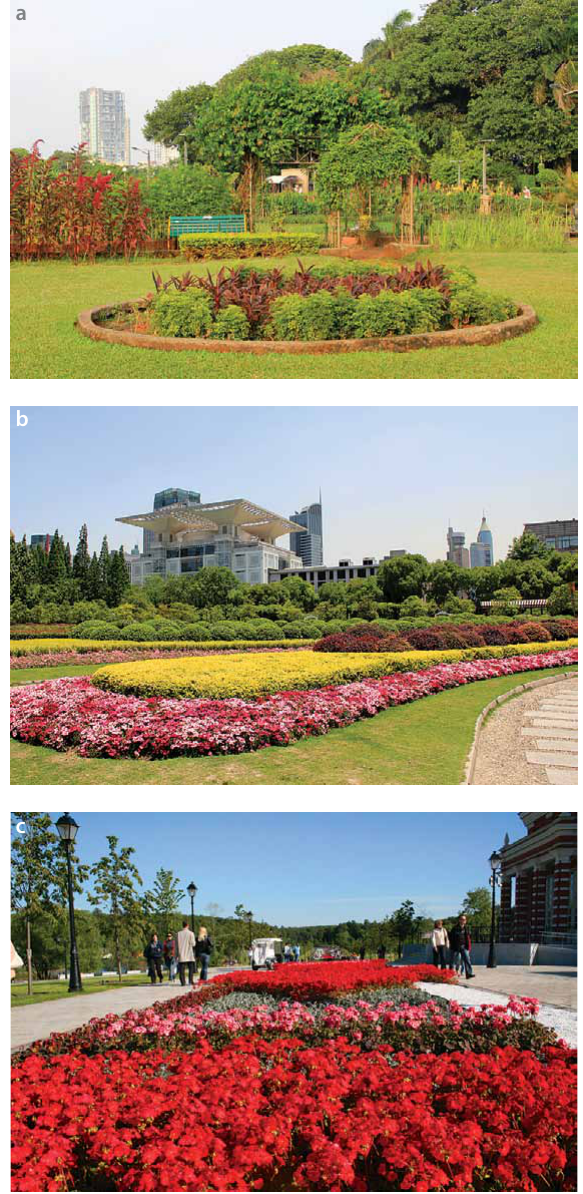
fig. 1. Examples of global